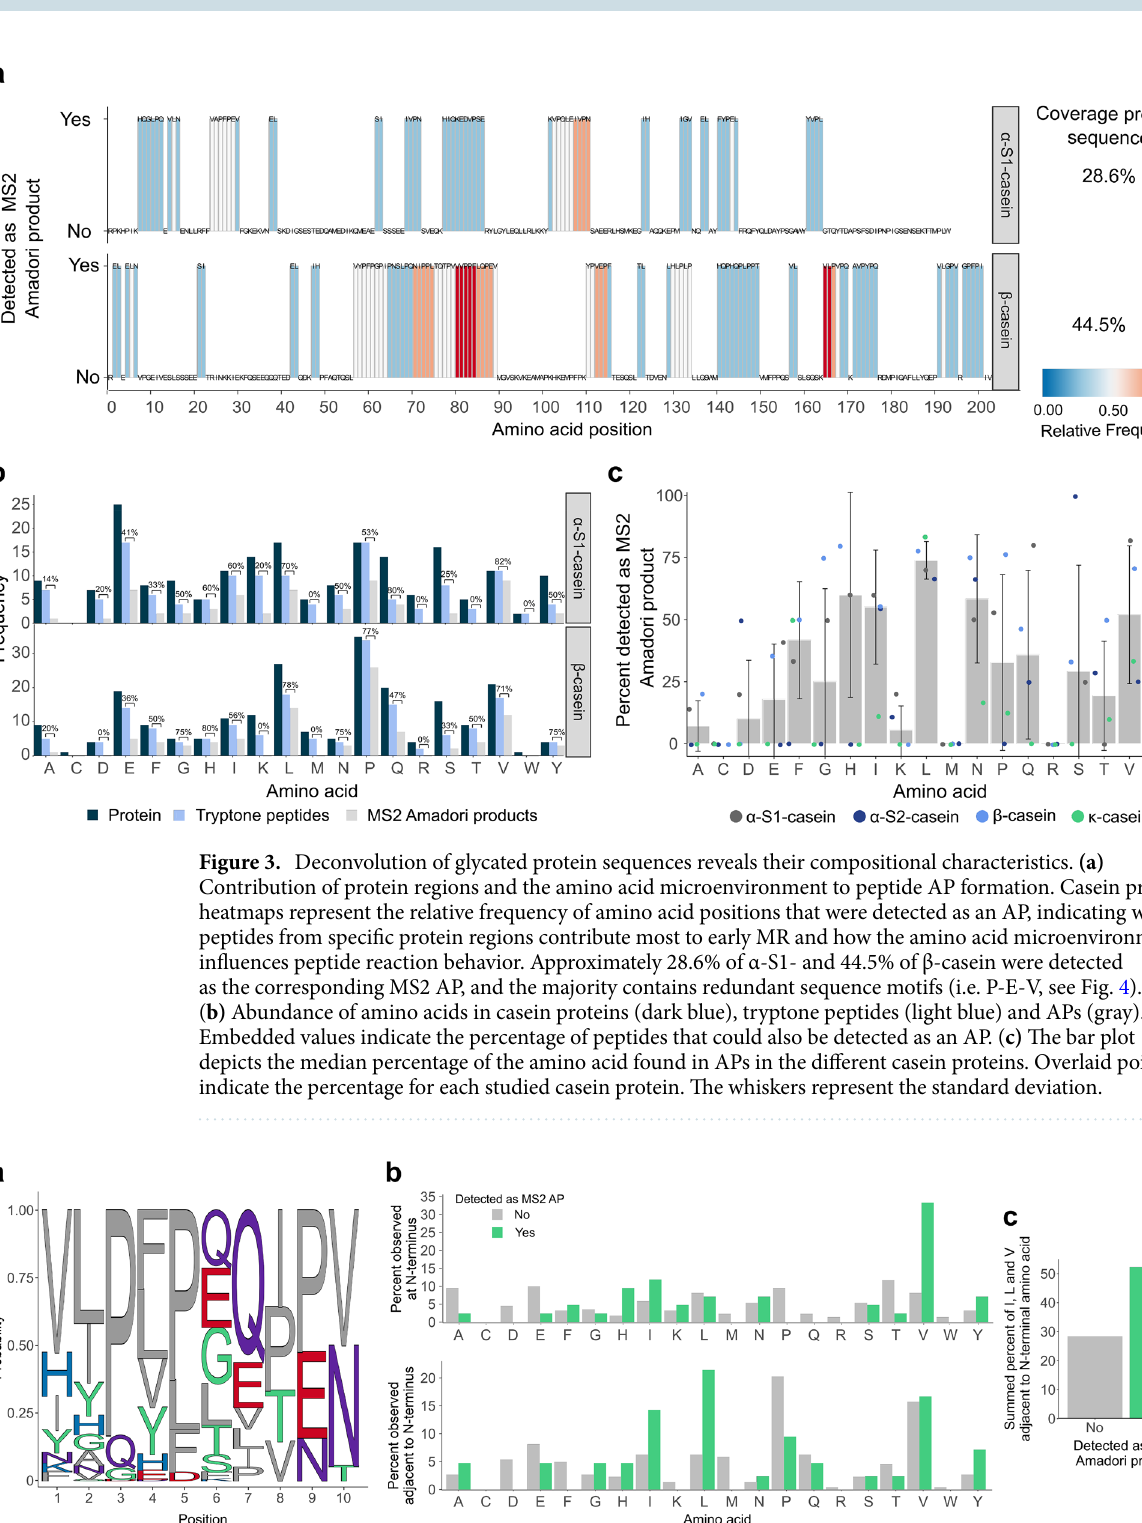
Figure 4. Analysis of the amino acid location relative to the glycation site reveals sequence-resolved changes in peptide reaction behavior. (a) Sequence logo representation of the first ten amino acid sequence positions of peptide APs. Amino acids with increased relative abundance in glycated peptides are illustrated (relative abundance glycated – relative abundance non-glycated > 0). ( b) Comparison of amino acids at the N-terminal position and adjacent to the peptide N-terminus. Bars show the percentage of (glycated) peptides that contain a given amino acid at the first (top) and second position (bottom) of the amino acid sequence (detected as AP: green bars; not detected as AP: gray bars). ( c) Summed percentage of peptides that contained isoleucine, leucine and valine adjacent to the N-terminal amino